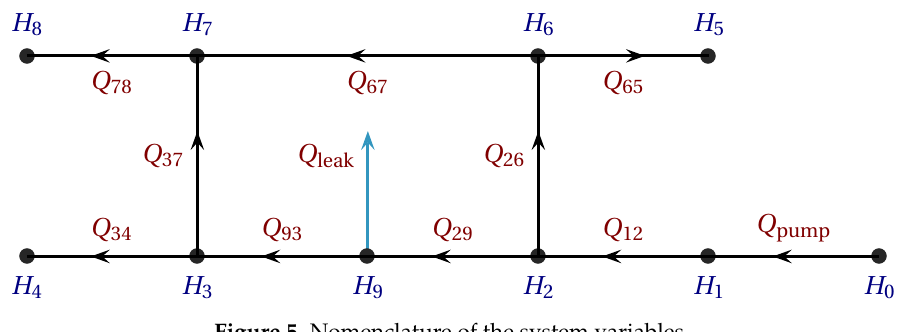
Figure 5. Nomenclature of the system